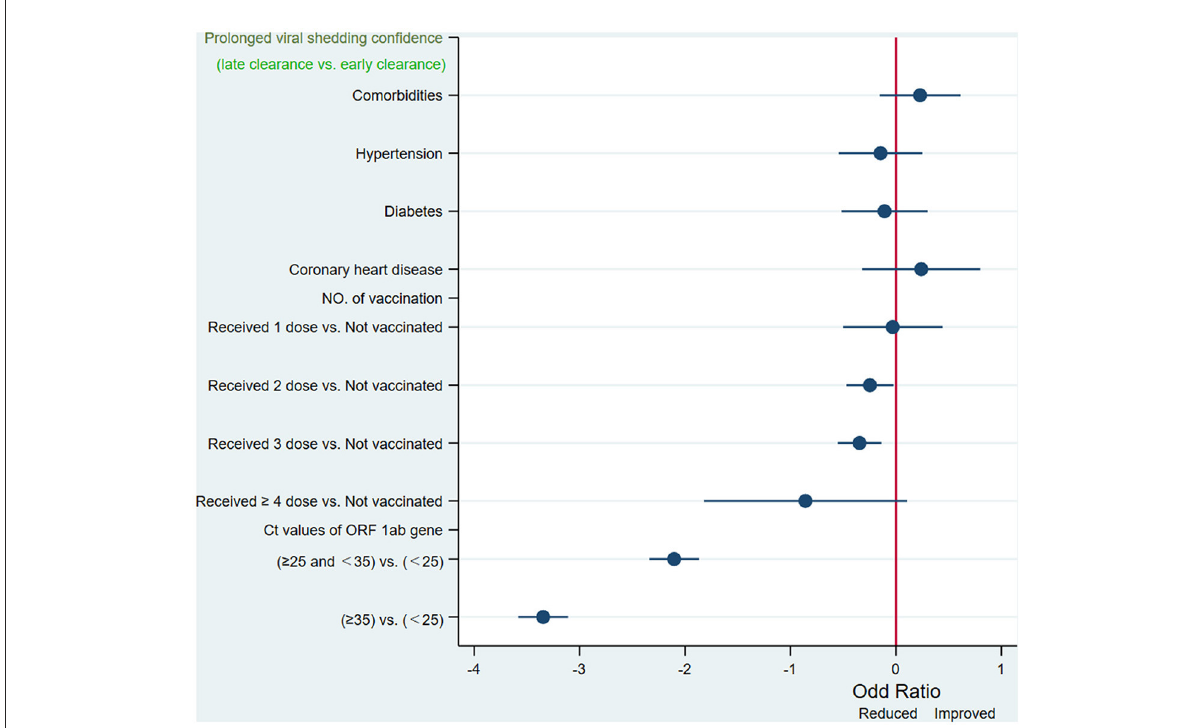
FIGURE3 Independent predictors of persistently PCR-positive patients identified by unadjusted multivariate logistic regression models logistic regression. Ct, cycle threshold; ORF 1ab gene, open reading frame 1ab.